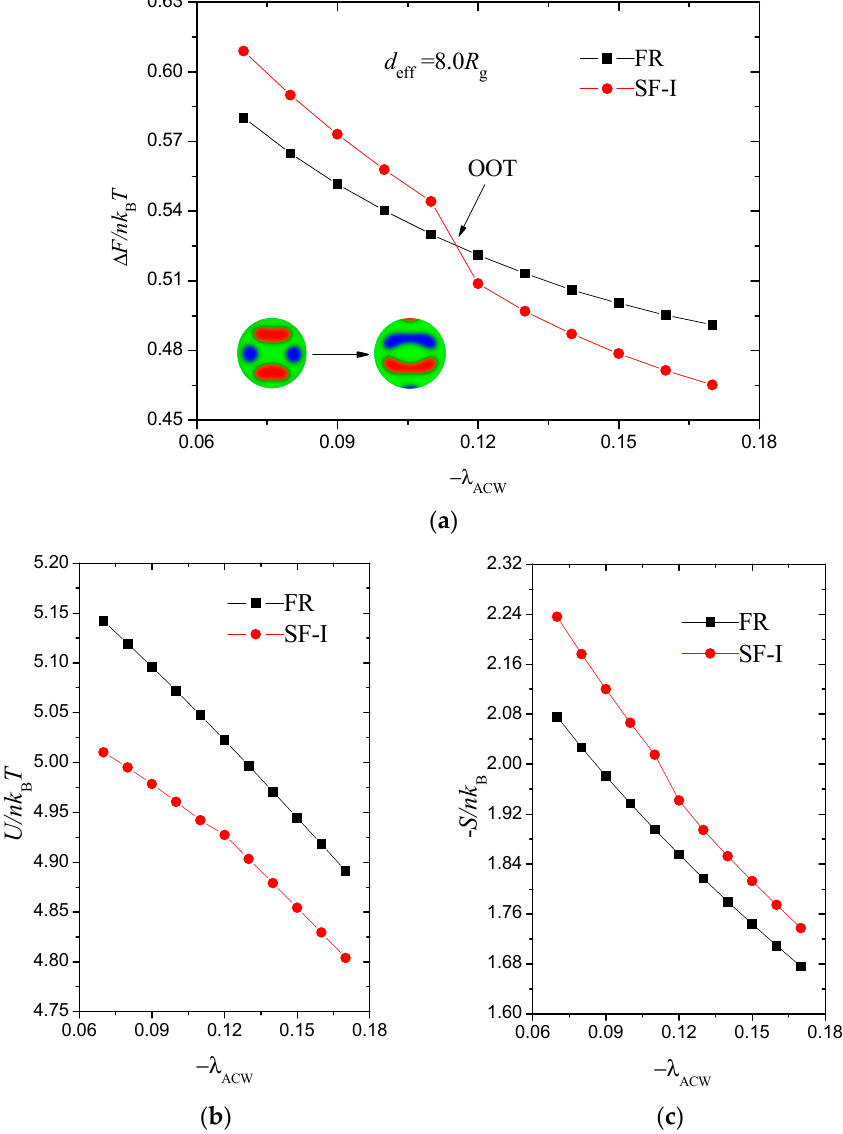
Figure 6. ( a ) Order-order phase transitions with AC-attractive intensity, −𝜆 (cid:2885)(cid:2887)(cid:2907) , when d eff = 8.0 R g . We subtract a linear function from the scaled free energies to highlight where the curves cross, and plot ∆𝐹 𝑛𝑘 (cid:2886) 𝑇⁄ = 𝐹 (cid:2923)(cid:2919)(cid:2924) 𝑛𝑘 (cid:2886) 𝑇 − (7.03 − 5.61|𝜆 (cid:2885)(cid:2887)(cid:2907) |)⁄ . ( b , c ) Internal energy, 𝑈 𝑛𝑘 (cid:2886) 𝑇⁄ , and entropic energy, −𝑆 𝑛𝑘 (cid:2886) 𝑇⁄ , contribute to the free energy in ( a ).